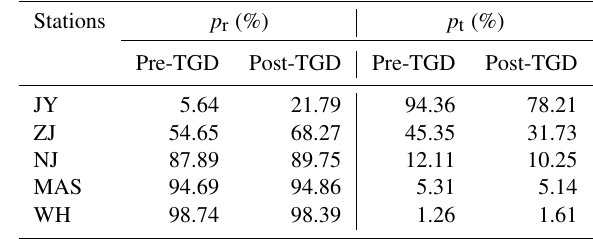
Figure 7. Alterations in river discharge and water level observed at DT and TSG, respectively, during the post-TGD period relative to the pre-TGD period over the climatological year. The daily aver- aged river discharge and water level were smoothed using a moving average filter with a span of 30d. Table 3. Relative contributions made by riverine p r and tidal p t forcing for both the pre-period and post-period at an annual